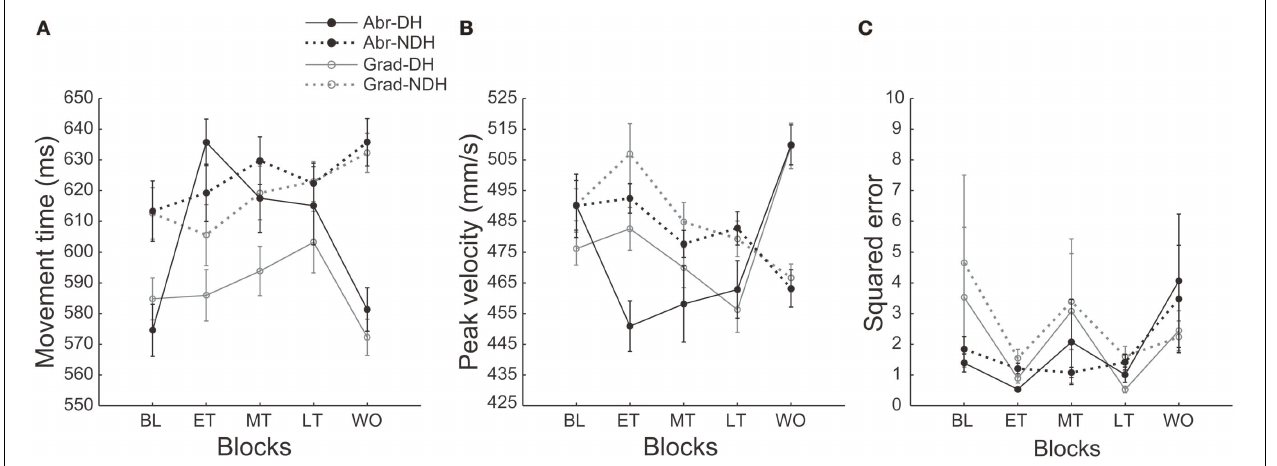
FIGURE 5 | Movement kinematics from the baseline block (BL), early training block (ET), middle training block (MT), late training block (LT), and the washout block (WO). Movement time (A) , Peak movement velocity (B) , and Accuracy of movement (C) are shown in